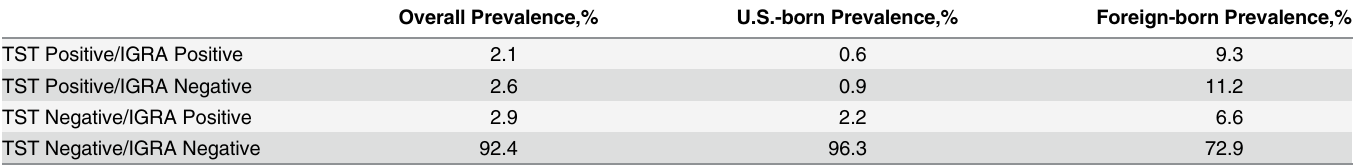
Table 6. Agreement between the Tuberculin Skin Test and Interferon Gamma Release Assay Test Results for Tuberculosis Infection in the Civilian, Noninstitutionalized U.S. Population, Ages 6+, 2011 – 2012. Overall Prevalence,% U.S.-born